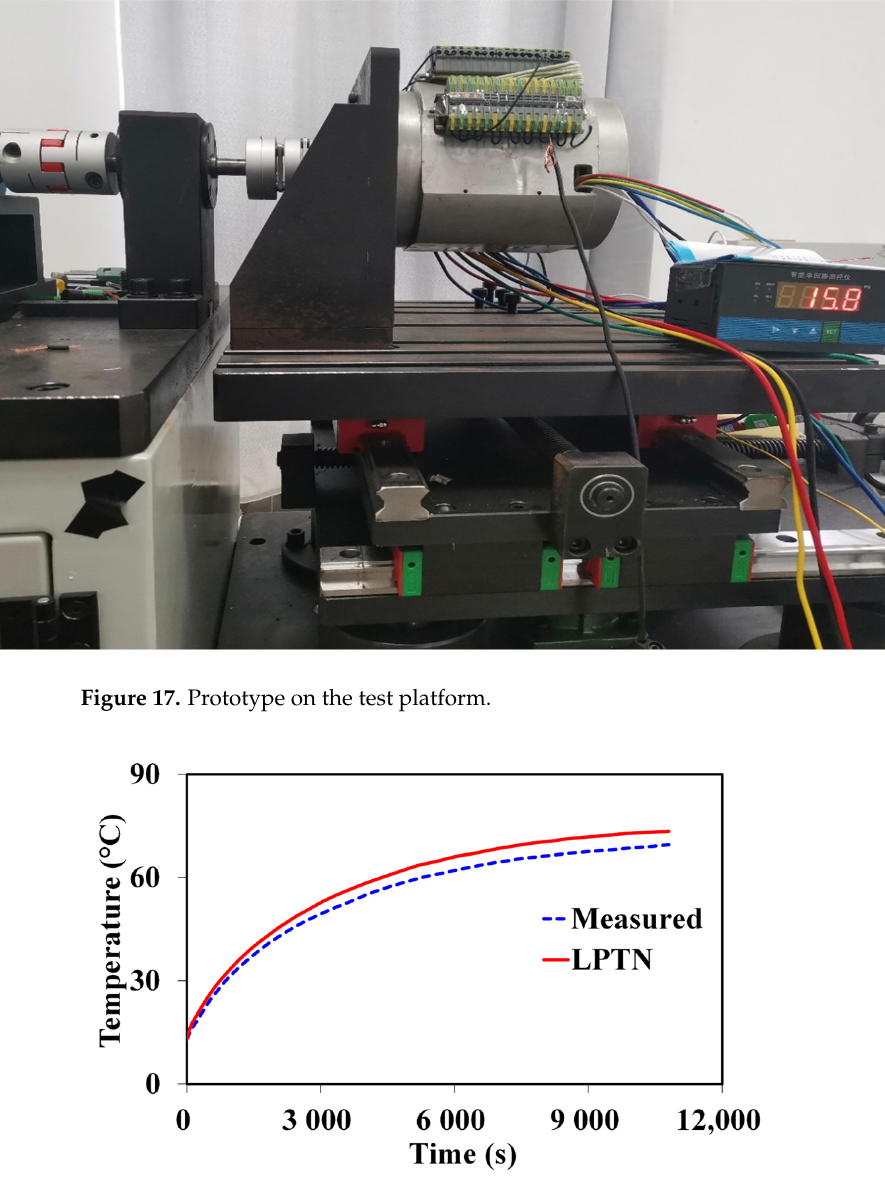
Figure 18. Temperature rise in winding under healthy conditions (900 r/min, 6 A).